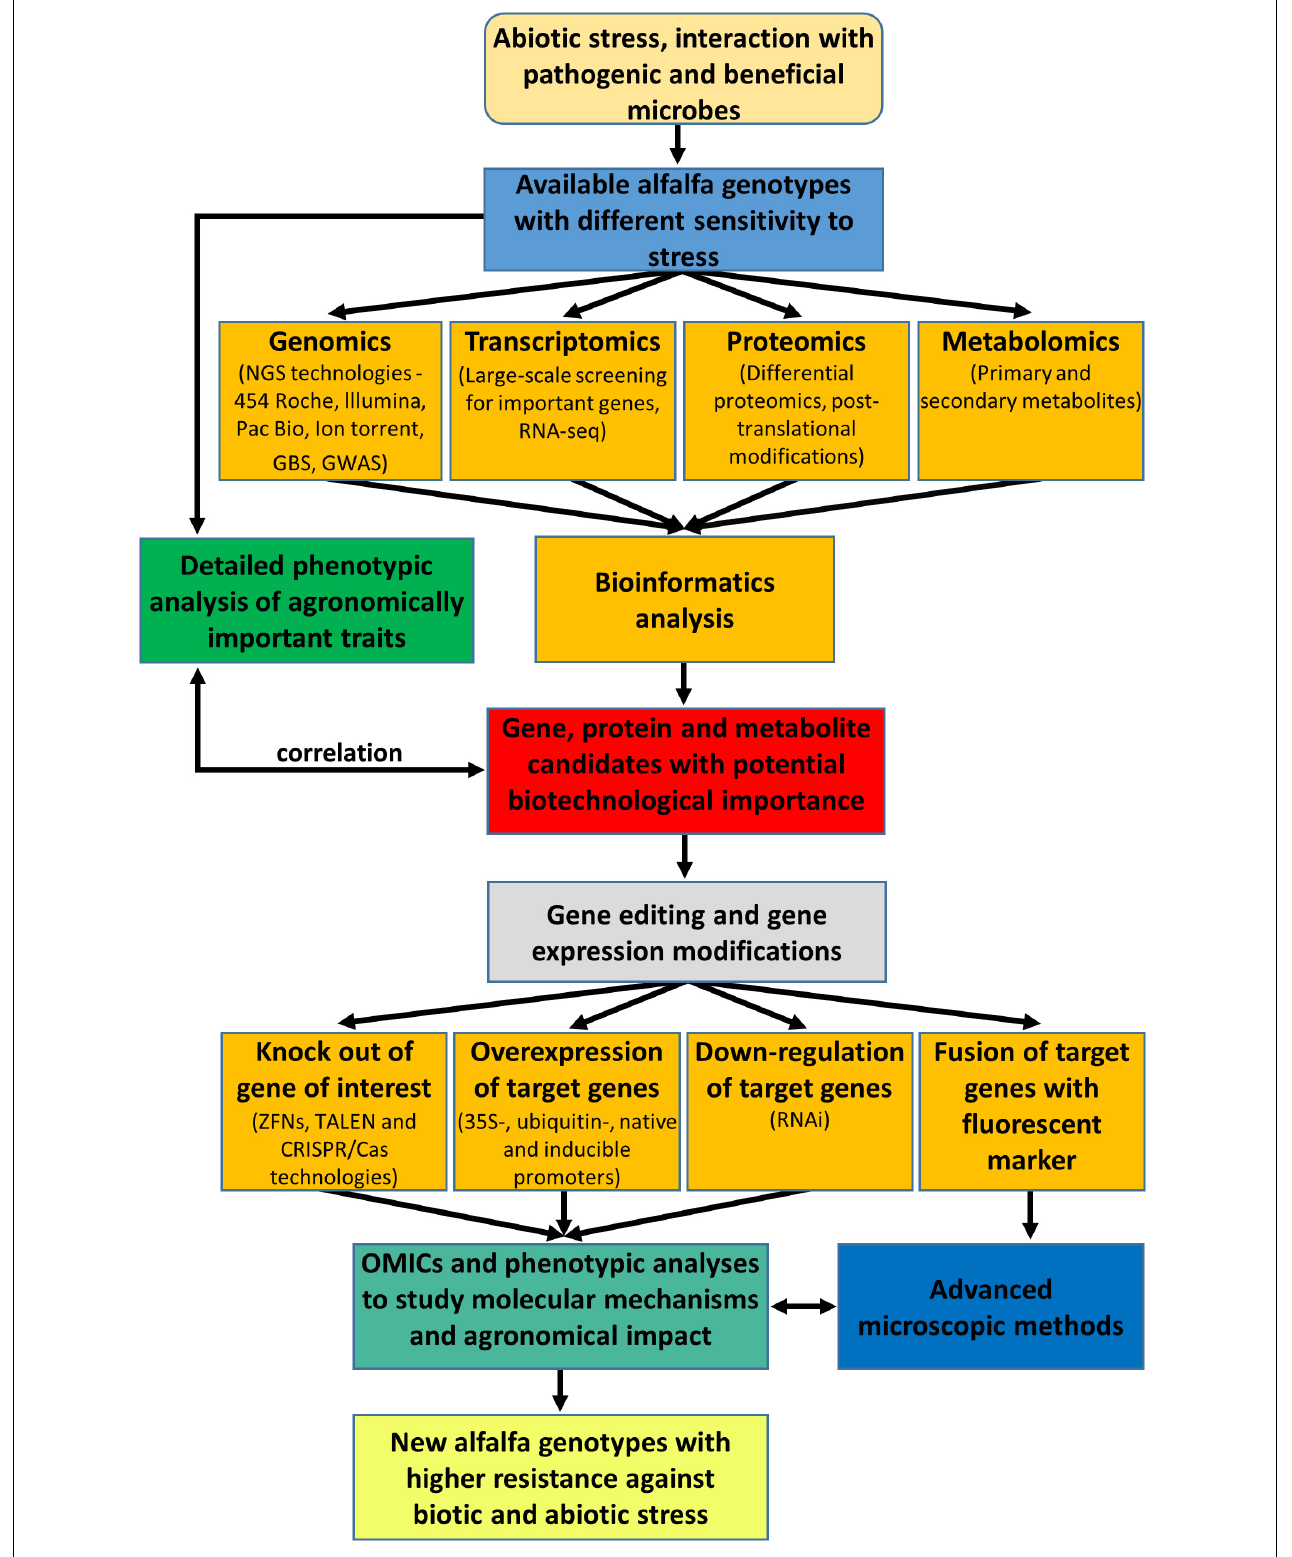
FIGURE 1 | Overview and integration of omics and molecular genetics approaches aiming to improve agronomic traits and performance of alfalfa.